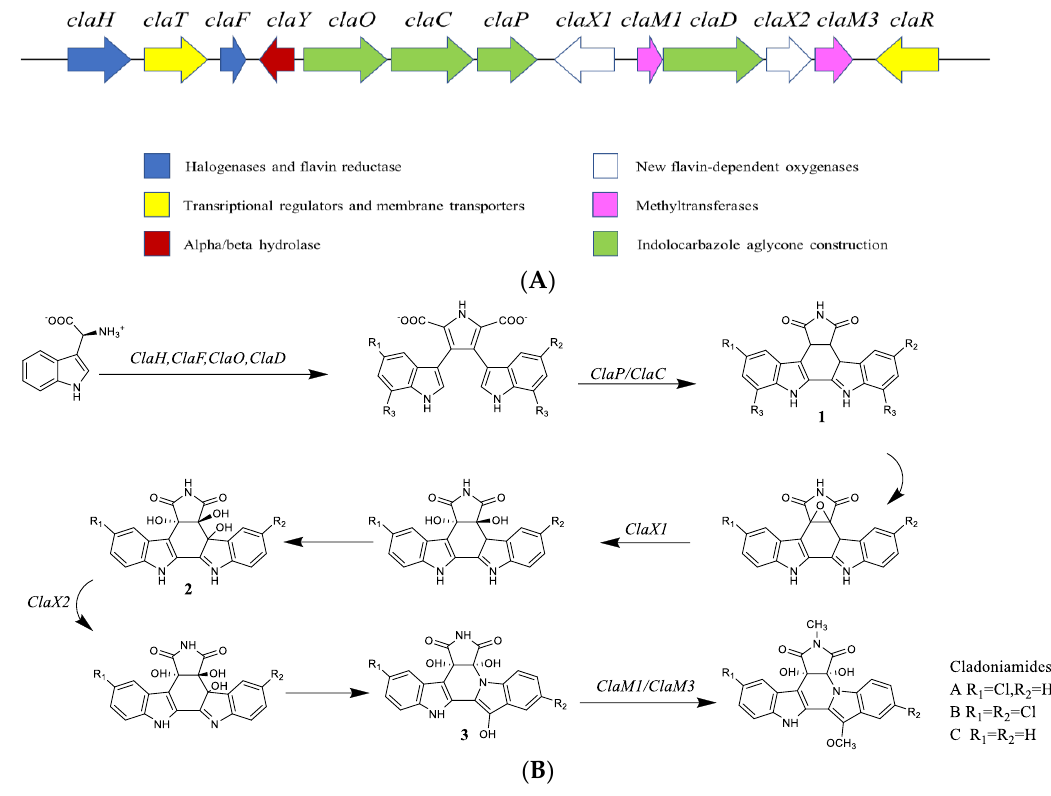
Figure 16. ( A ) The gene clusters of cladoniamides. ( B ) The biosynthetic pathway of cladoniamides A − C [74].